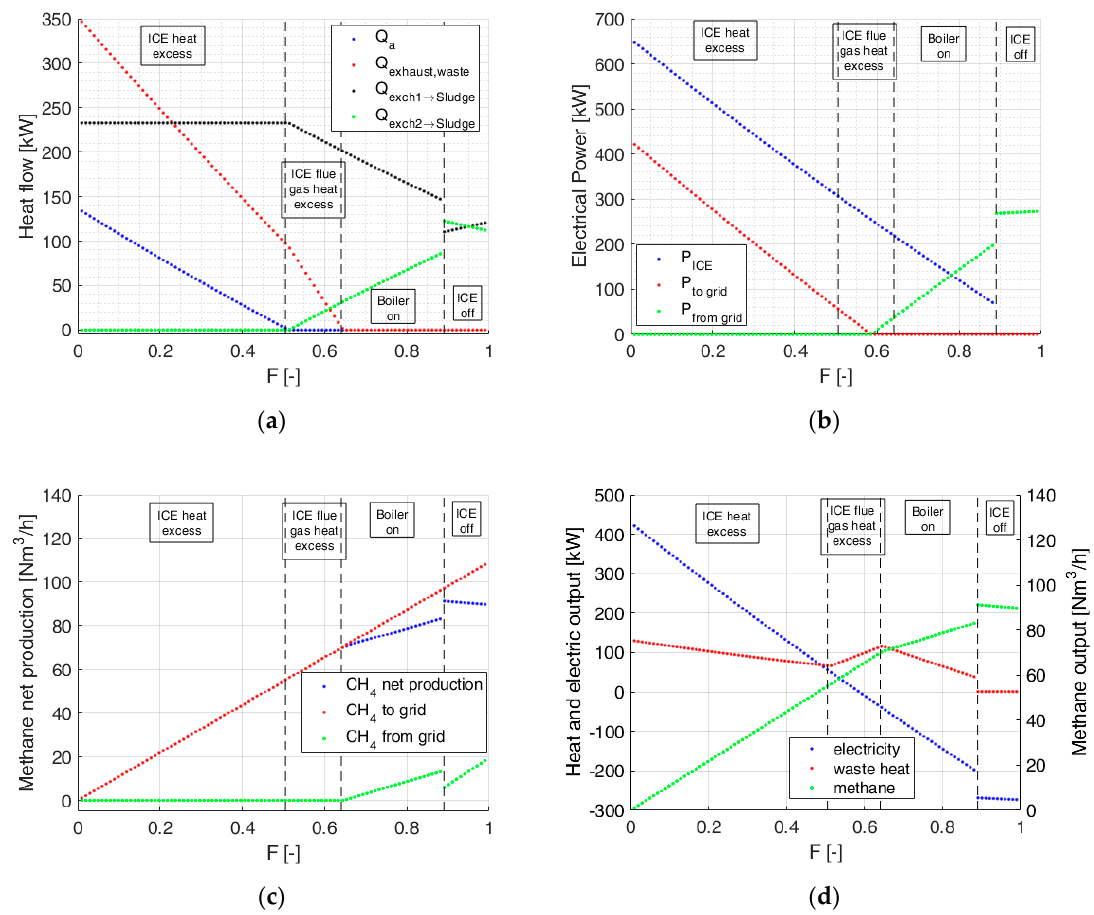
Figure 4. ( a – d ) Heat and mass flows calculated by the simulation.